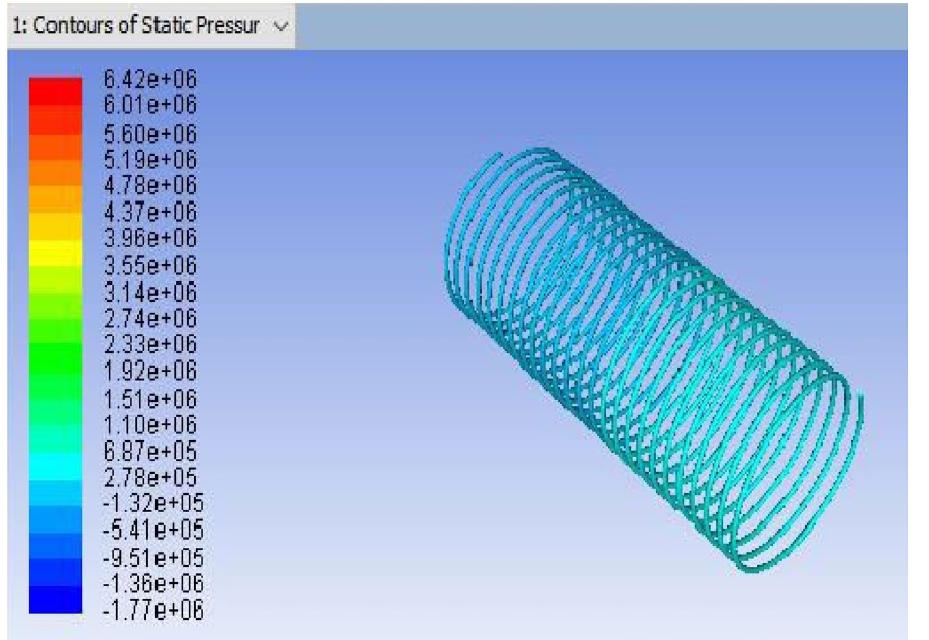
Figure 15. ANSYS Fluent solution of static pressure for capillary coil 3 (3.96